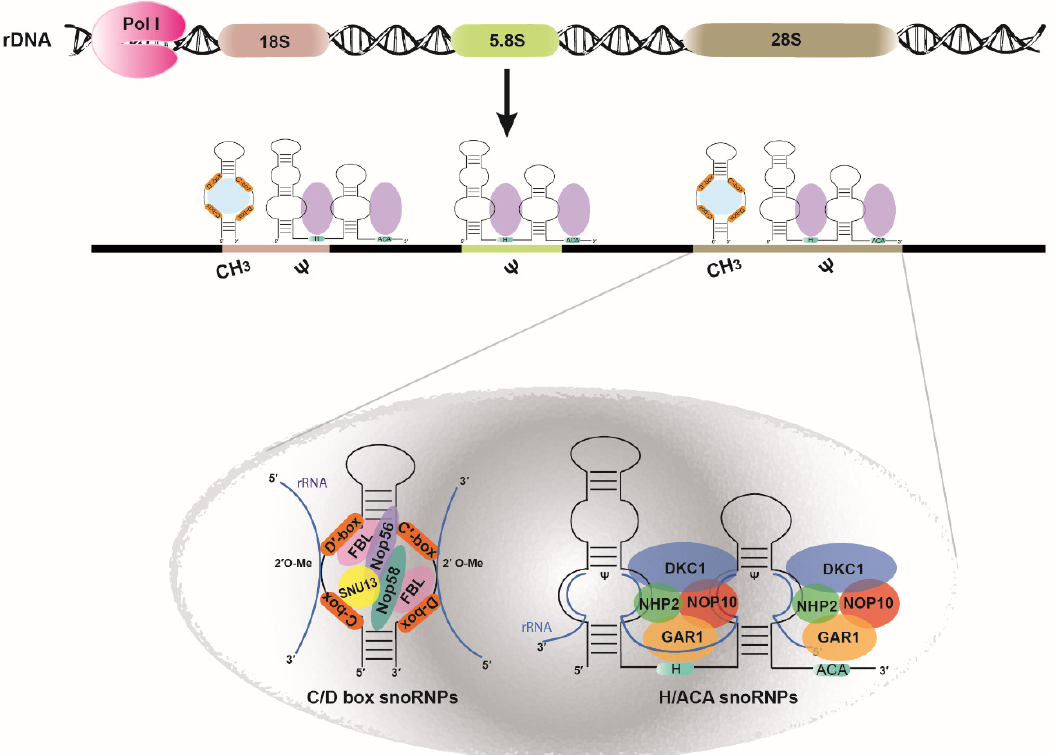
Figure 6. Schematic representation of snoRNAs involved in pre-rRNA modification. C/D and H/ACA snoRNPs (small nucleolar ribonucleoproteins) hybridize on pre-rRNA at specific sites that undergo 2 ′− O methylation and pseudouridylation, respectively. (Lower panel) The C/D box snoRNA contains the conserved C and D motifs where the site-specific 2 ′ -O methylation of the target rRNA is catalyzed by fibrillarin (FBL). In addition, for an active C/D snoRNP, the proteins SNU13(15.5K), NOP58 and NOP56 are also required. The H/ACA snoRNAs harbor the conserved H and ACA elements that form two pseudouridylation pockets, where pseudouridylation of the target rRNA is catalyzed by dyskerin (DKC1). The core proteins NHP2, NOP10, GAR1 are essential for a functional H/ACA snoRNP. Moreover, deficiency of the catalytic snoRNP proteins is the cause of many diseases. For instance, mutations in DKC1 have been observed in X-linked Dyskeratosis congenita (X-DC), a disorder characterized by hematopoietic defects and cutaneous abnormalities [101]. These mutations affect the level of rRNA pseudouridylation and selectively promote the IRES-dependent translation of specific mRNAs, like that of the growth factor VEGF, which in turn explains the increased cancer risk of X-DC patients [102 – 104]. In addition, loss of SNORA24, which directs Ψ 609 and Ψ 863 formation on the 18S rRNA, combined with the oncogenic RAS expression promotes cancer [105]. Precisely, Ψ 609 is located in the ribosome’s decoding center, and therefore lack of this modification leads to faulty tRNA selection and ribosome translocation. Overall, several snoRNAs with aberrant expression have been related to cancer but their exact consequences on ribosome biogenesis remain unknown [98]. A distinct group of snoRNA with no characteristic primary sequence motif forms the RNA component of RNase MRP (RMRP). In human, RMRP is transcribed by RNA pol III, while its yeast homolog, NME1 (nuclear mitochondrial endonuclease 1) is transcribed by RNA pol II [106,107]. In fact, RMRP is the catalytic subunit of the bifunctional ribonucleoprotein RNase MRP which is involved not only in the mitochondrial DNA replication, but also in the pre-rRNA cleavage at the A3 site in the nucleolus [108]. RMRP is well-conserved among organisms, but its exact role was controversial. This RNA was recently found to mediate the human pre-rRNA ITS1 (Internal transcribed spacer 1) cleavage at site 2 [109]. Approximately 100 distinct mutations in RMRP that